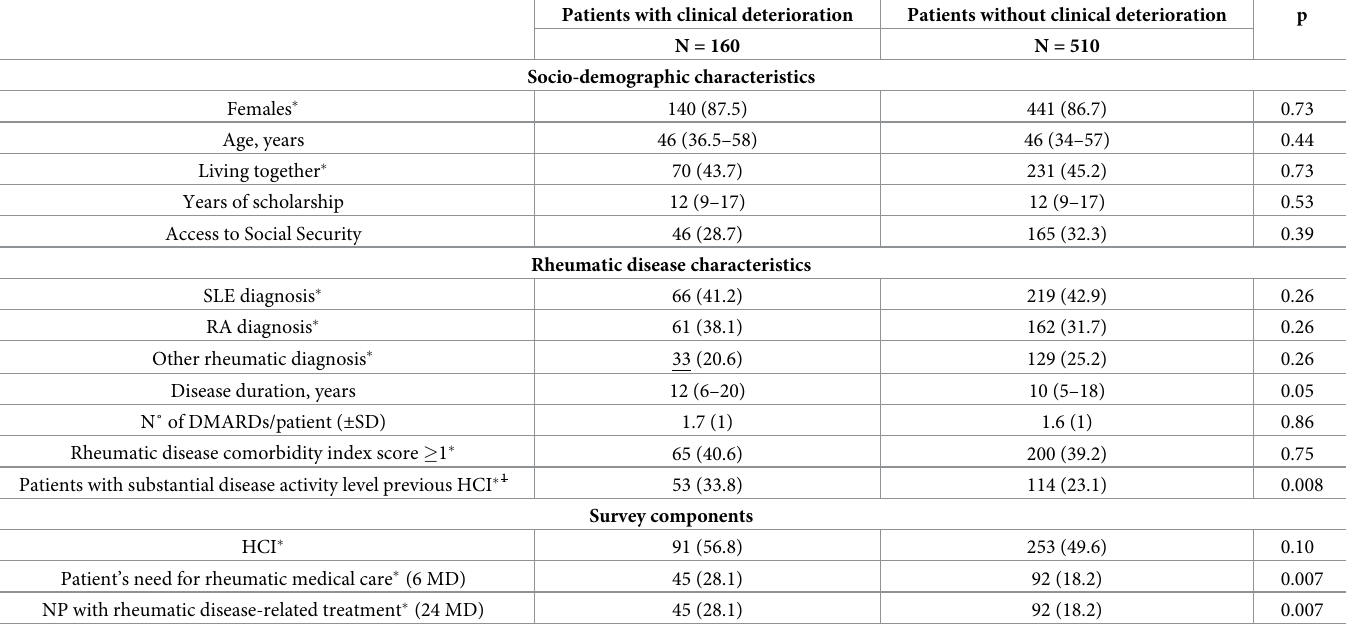
Table 5. Comparison of characteristics between patients with clinical deterioration and their